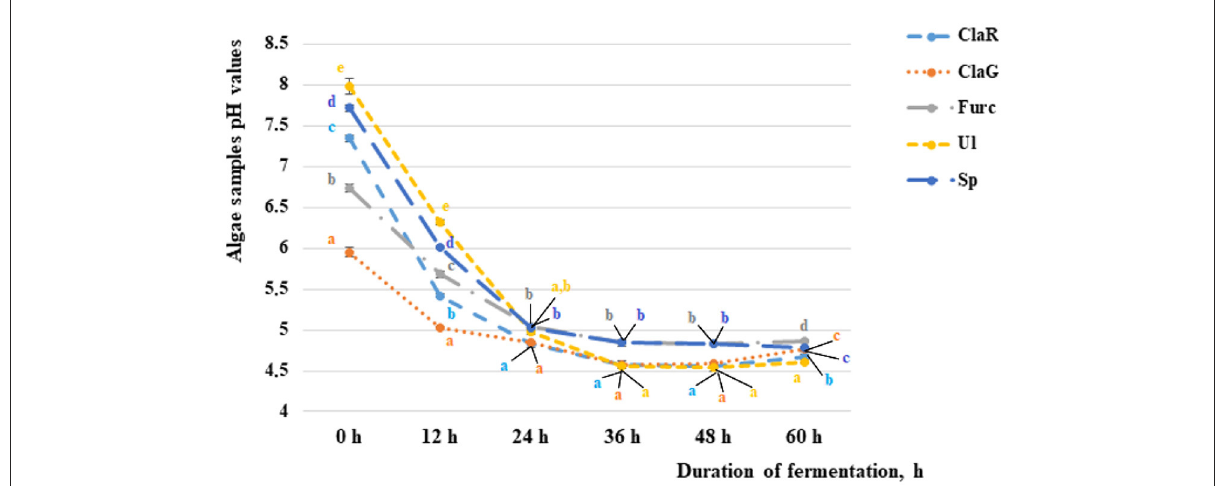
FIGURE2 The pH of the non-fermented and fermented algae samples after 12, 24, 36, and 60h of fermentation [ClaR - Cladophora rupestris ; ClaG - Cladophora glomerata ; Ul - Ulva intestinalis ; Furc - Furcellari lumbricalis ; Sp - Spirulina ( Arthrospira platensis )]. Data are represented as means ( n = 3) ± SE. Means with different letters (a–e) are significantly different ( p ≤ 0.05). The color of the letters coincides with the color of the sample in the graph.